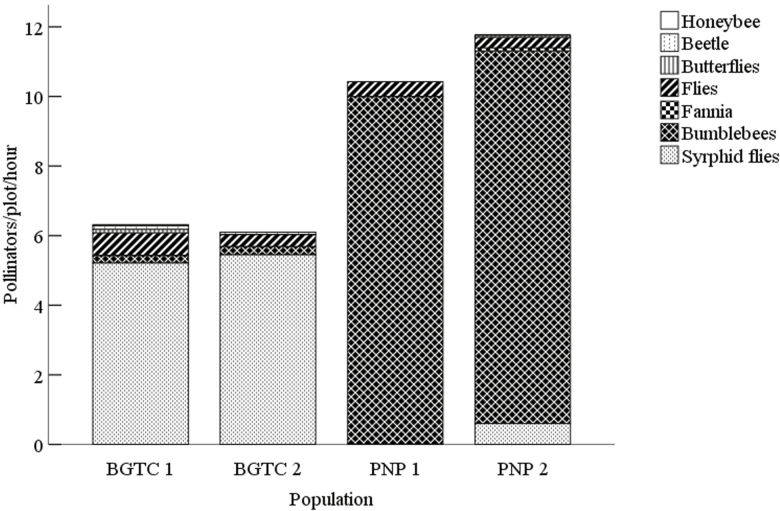
Results of pollinator observations conducted in the four Primula secundiflora populations. Bumblebees comprised Bombus atrocintus, B. convexus, B. richardsi and B. lucorum.